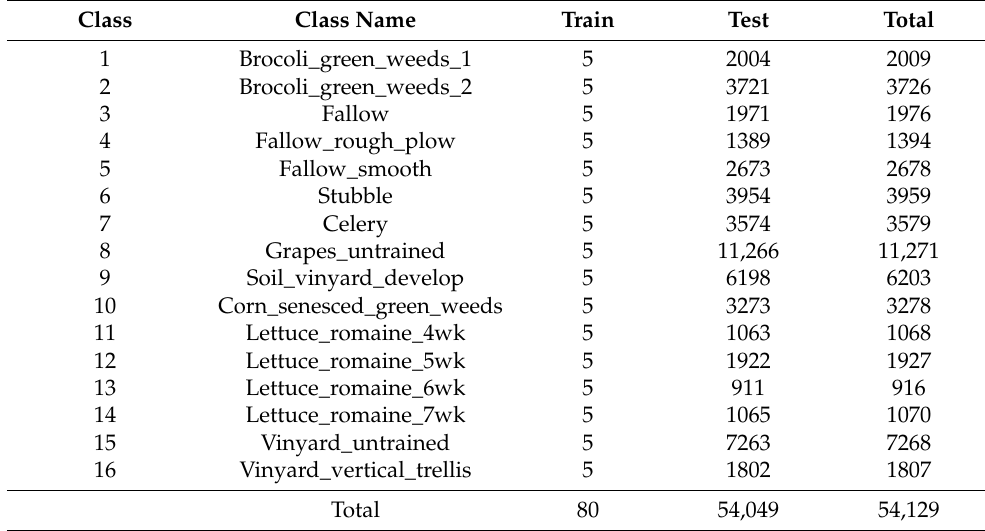
Table 3. The Numbers of Training, Testing, and Total Samples in SV